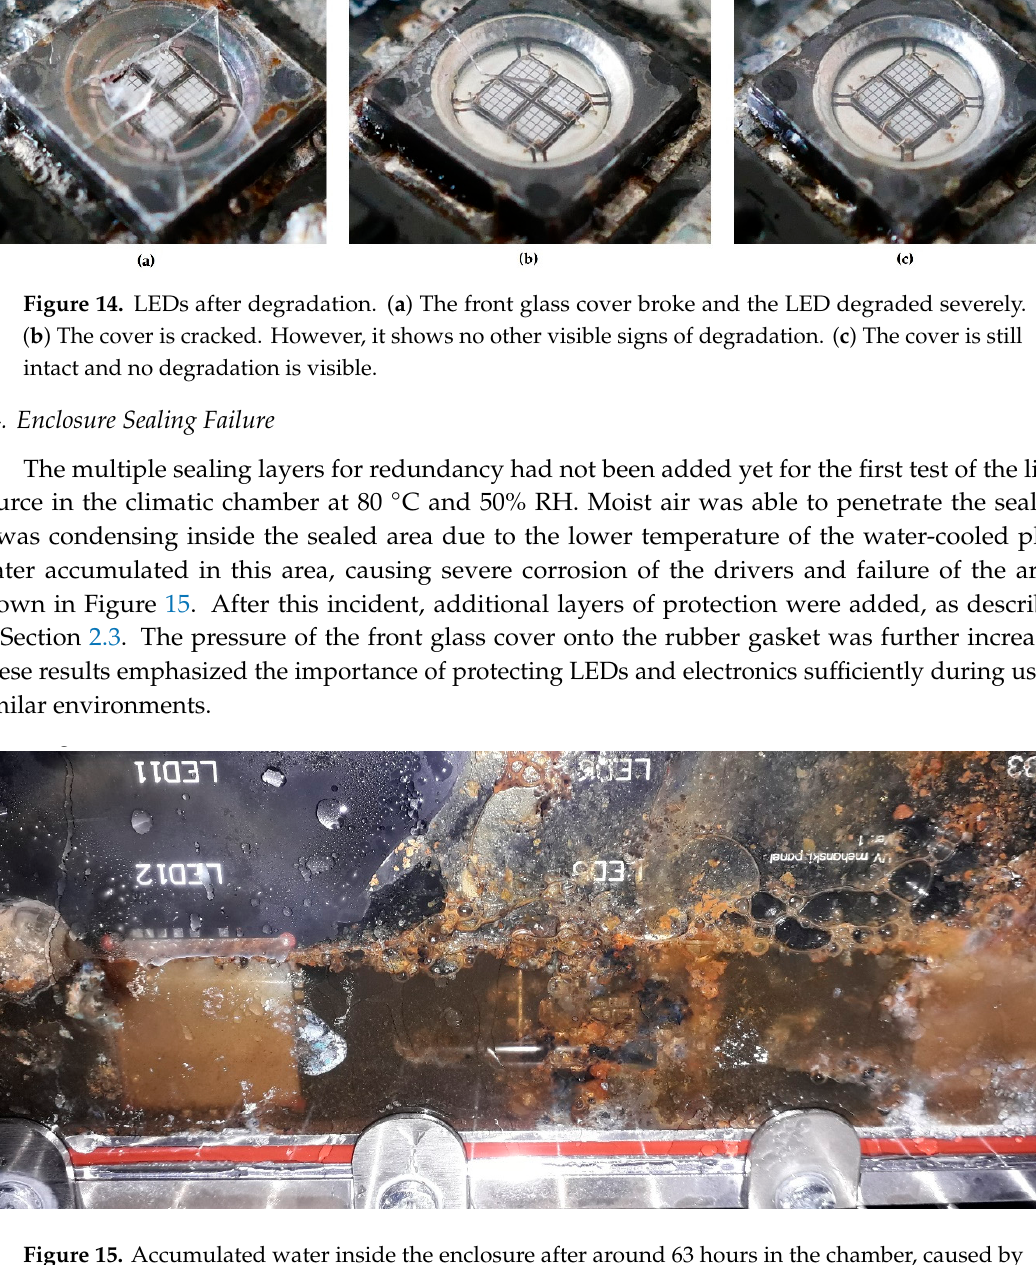
(green) climatic chamber tests. The dashed lines show outliers.